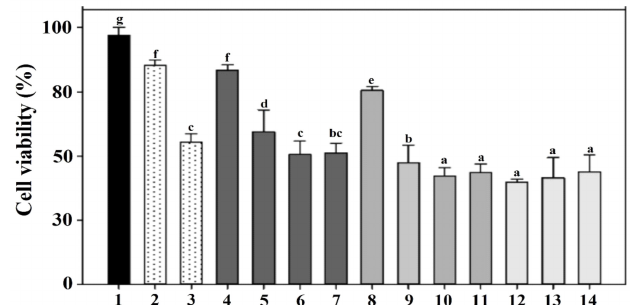
Figure 4. To determine cytotoxicity, murine macrophages RAW 264.7 were exposed to PBS buffer (bar 1); 5 and 50 µ g/mL LPS from Escherichia coli (bars 2–3); 3.7 × 10 6 , 3.7 × 10 7 , 3.7 × 10 8 , 3.7 × 10 9 CFU per mL of HCl-induced LMGs (bars 4–7); NaOH-induced LMGs (bars 8–11); and 3.7 × 10 6 , 3.7 × 10 7 , 3.7 × 10 8 CFU per mL of wild-type L. monocytogenes (bars 12–14), respectively. Macrophages at 24 h post-exposure were collected for analysis of cell viability using a Cell Counting Kit-8. Ab- sorbance was measured at 450 nm, and all experiments were performed in triplicate. All data are expressed as the mean ± the standard error of the mean. The letters above bars represent a significant difference between treatments ( p <